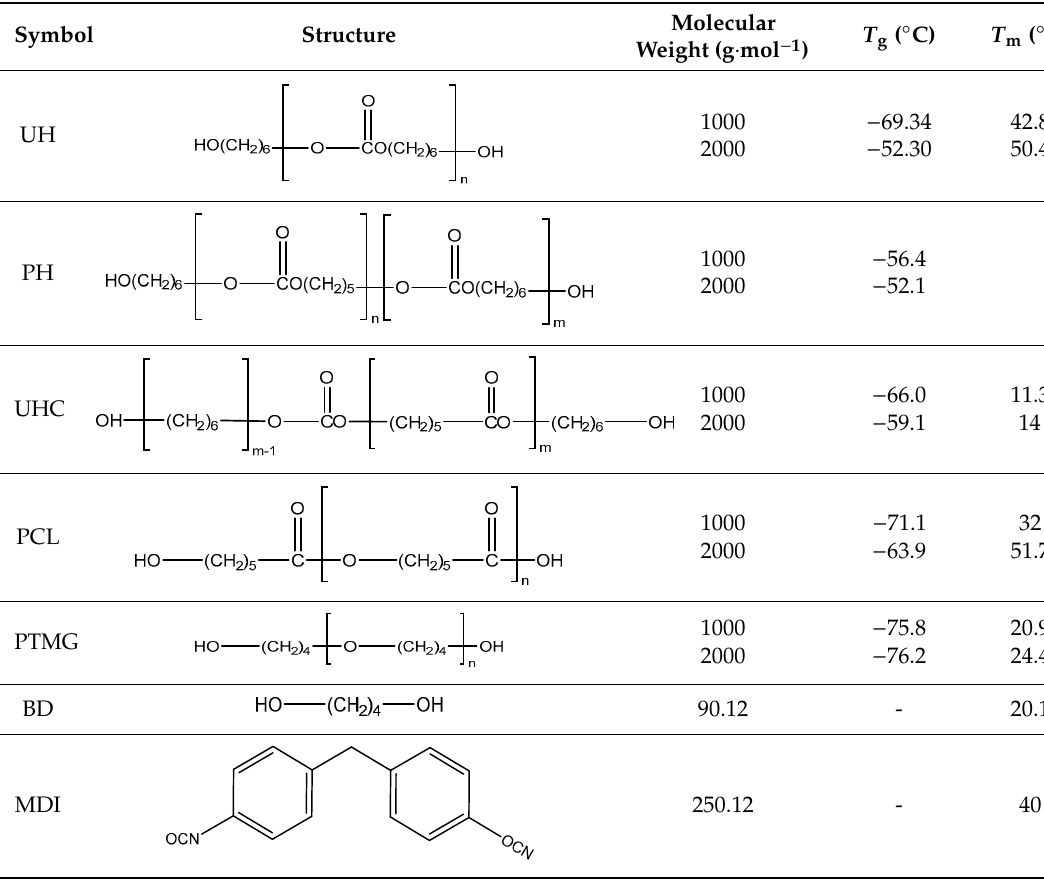
Table 1. Symbol, structure, molecular weight, glass transition temperature ( T g ), and melting temperature ( T m ) of the pure materials used. UH, poly(hexamethylene) carbonate diol; PH,